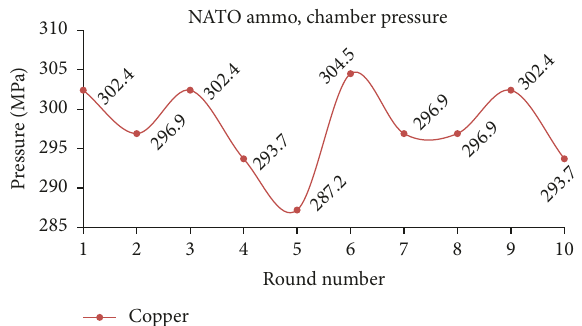
Figure 26: Chamber pressure measured with copper crusher using standard NATO ammunition.